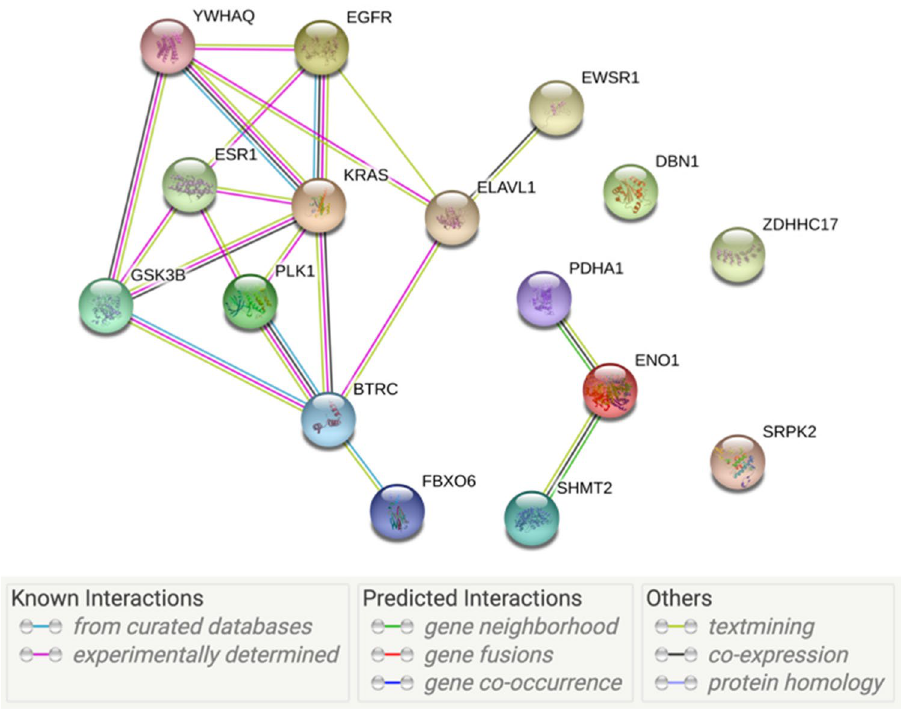
Figure 4. STRING analysis of 16 selected genes. Links between genes represent known interactions (from experimental evidence / curated database) or predicted